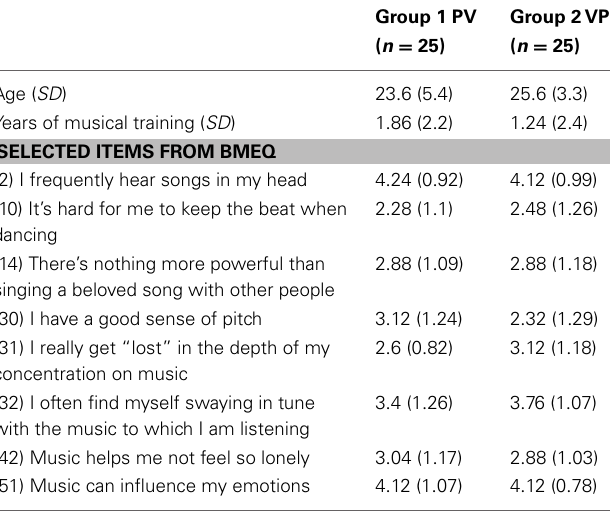
Table 1 | Age and musical background and attitudes of the subjects.